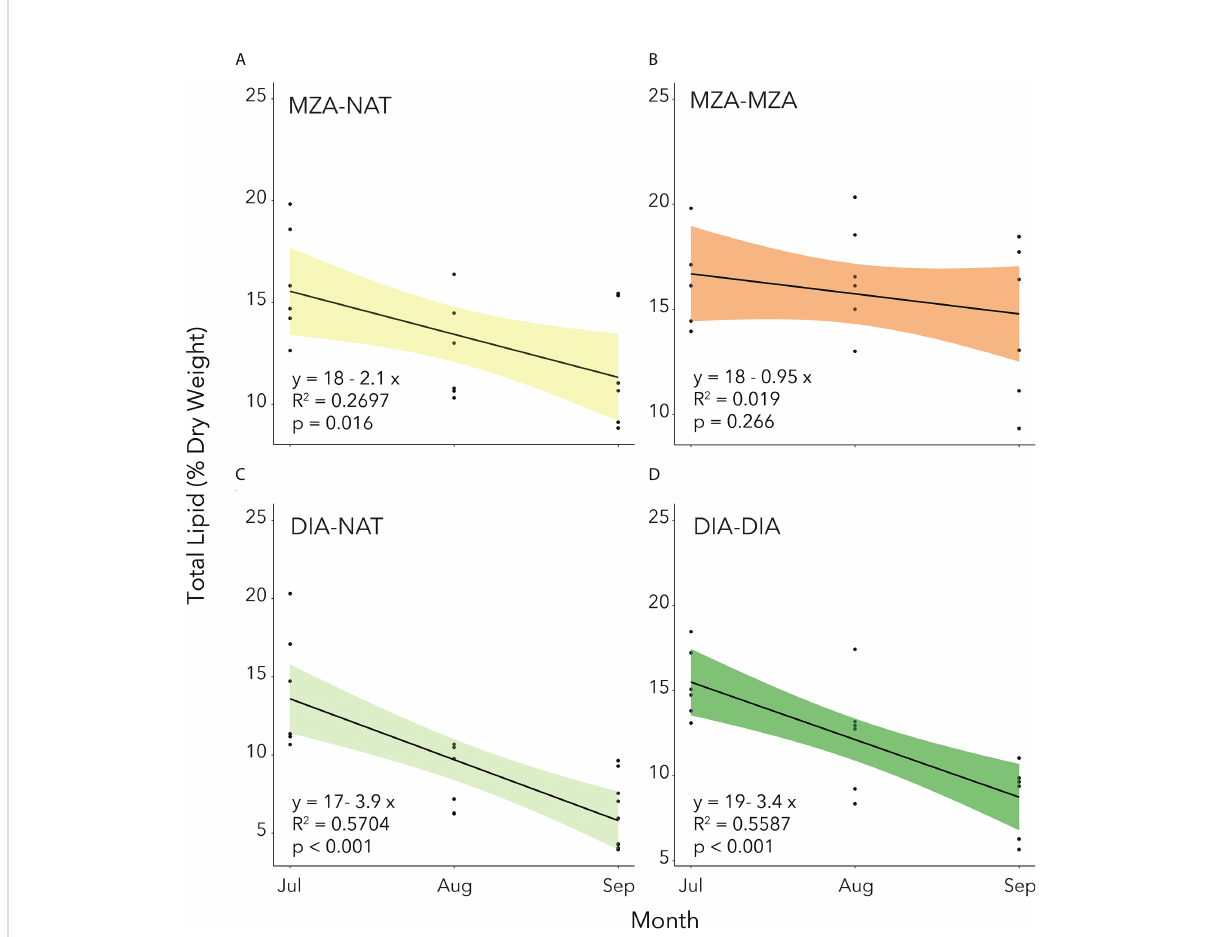
FIGURE 5 Total lipid content as a percentage of dry weight (mg) of juvenile krill in the four different feeding environment scenarios. (A) MZA-NAT = fed a mixed zooplankton assemblage for 2 months and then switched to natural un fi ltered seawater for the remaining 2 months. (B) MZA-MZA = fed a mixed zooplankton assemblage for the full 4-month period. (C) DIA-NAT = fed cultured diatoms for 2 months and then switched to natural un fi ltered seawater for the remaining 2 months. (D) DIA-DIA = fed cultured diatoms for the full 4-month period. Total lipid utilization is calculated as the slope of the linear regression of total lipid content over time